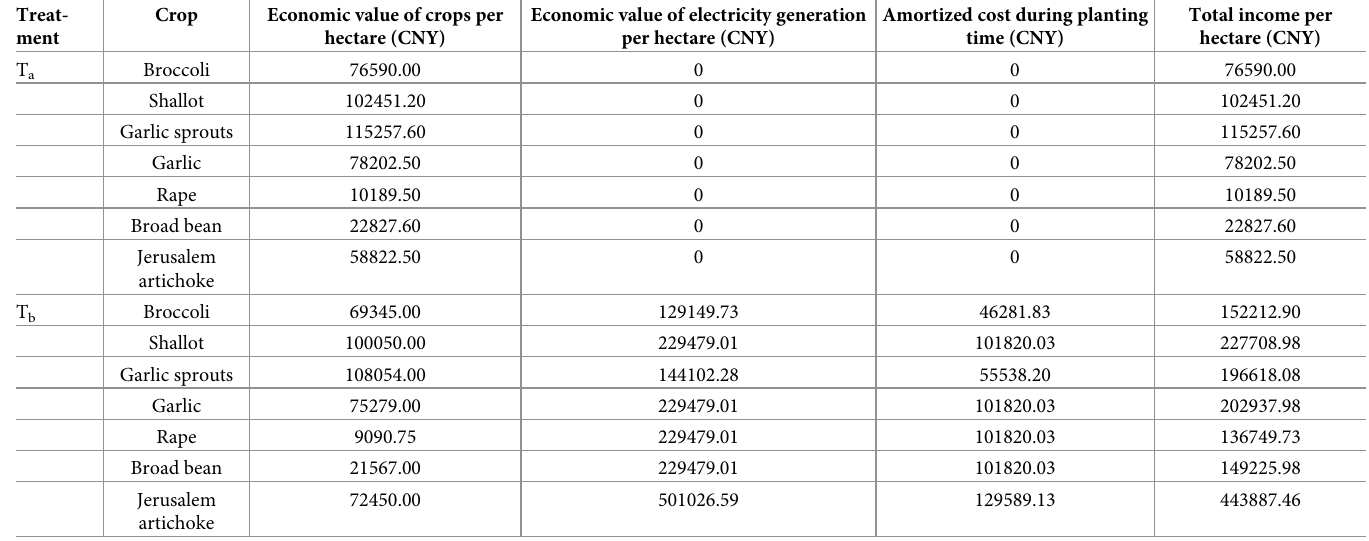
Table 8. Economic benefits per hectare of land in two cultivation methods.